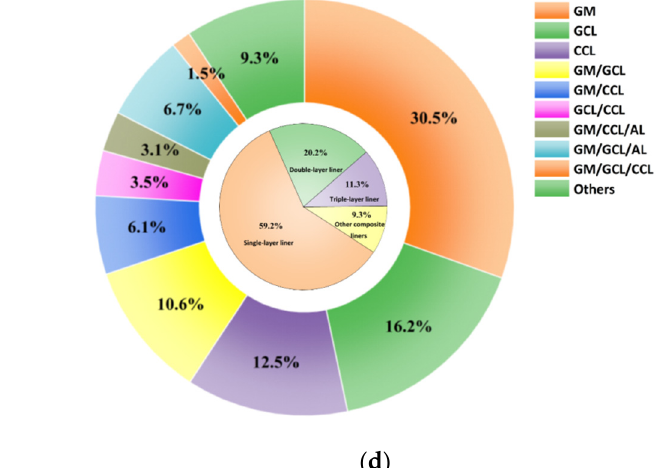
Figure 2. Research trend and progress in recent decades: ( a ) The number of related papers for last 20 years; ( b ) The number of researchers and examined approaches; ( c ) The number of related papers in different countries; ( d ) The percentage of pollution-sealing approaches.